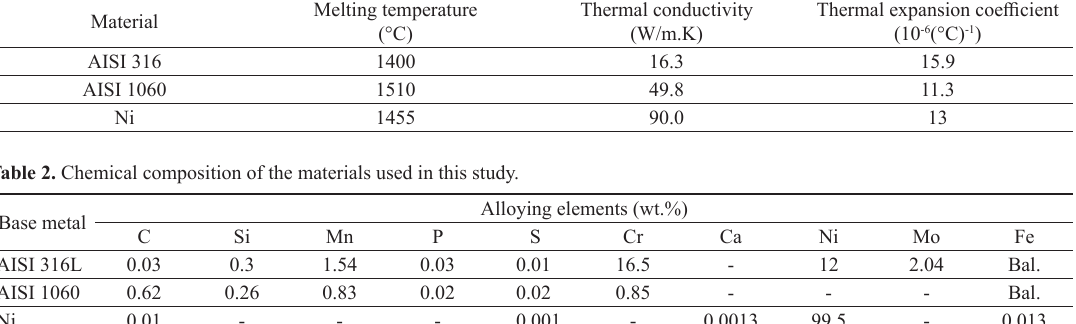
Table 1. Physical properties of AISI 316 stainless steel and AISI 1060 carbon steel 20 . Material